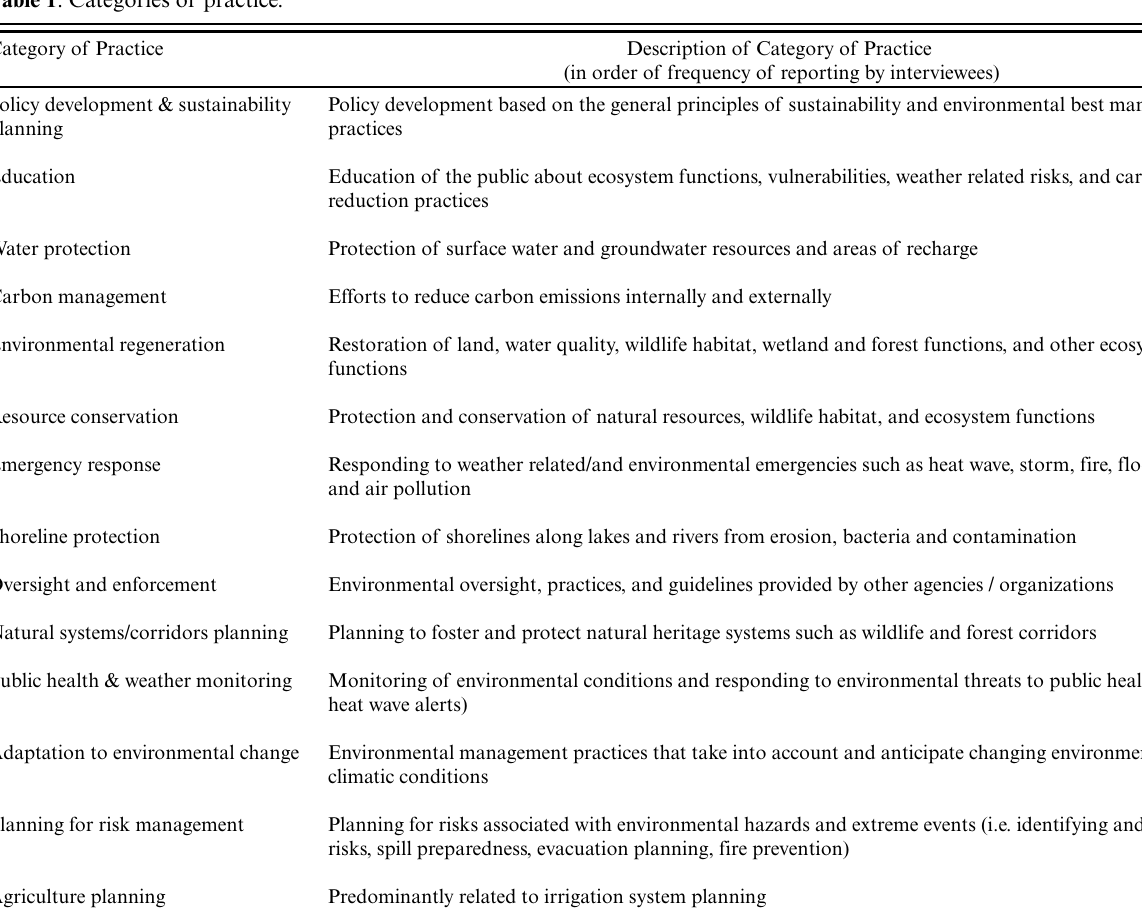
Table 1 . Categories of